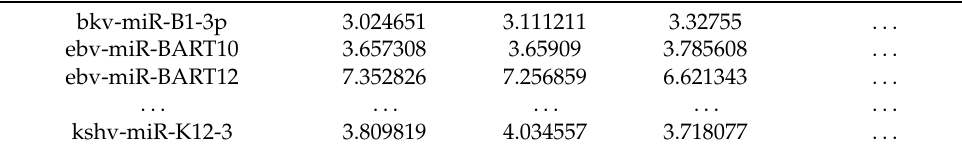
Table 2. Example of miRNA